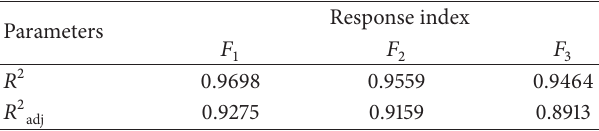
Table 2: The ANOVA table of mean for the approximation model.